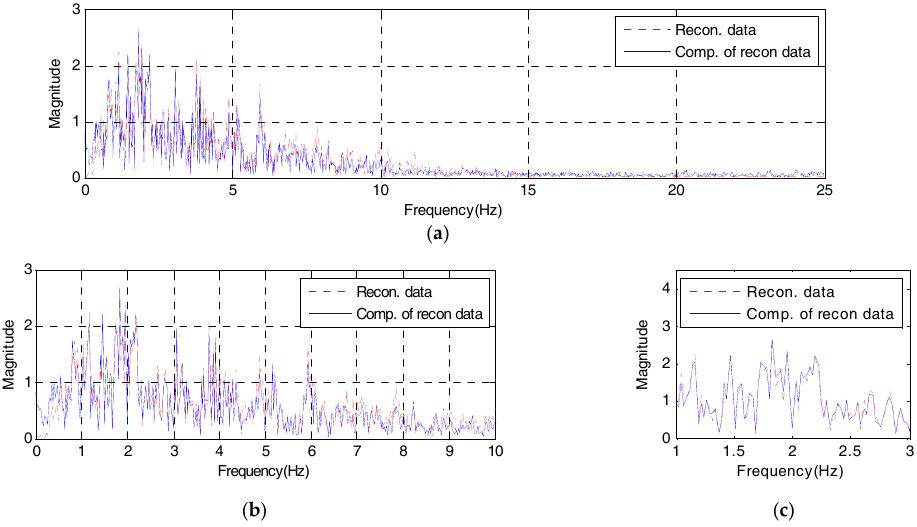
Figure 18. Frequency domain of compressive signal using peak-picking values: ( a ) frequency from 0 to 25 Hz; ( b ) Detail 1; ( c ) Detail 2.